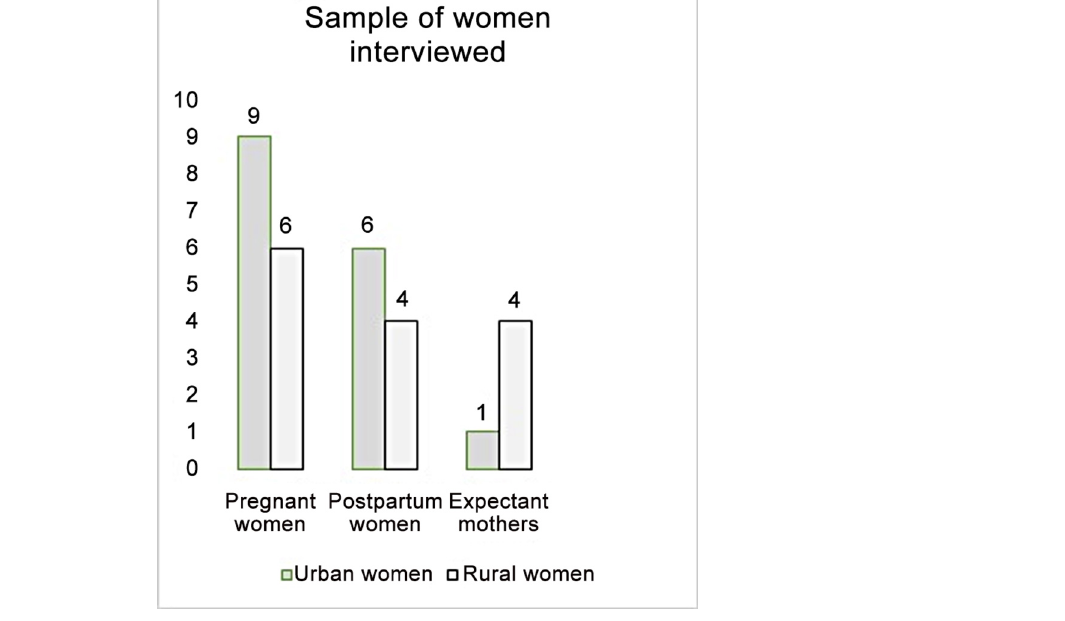
Fig 1. Sample of women interviewed. Source: Created by the authors.